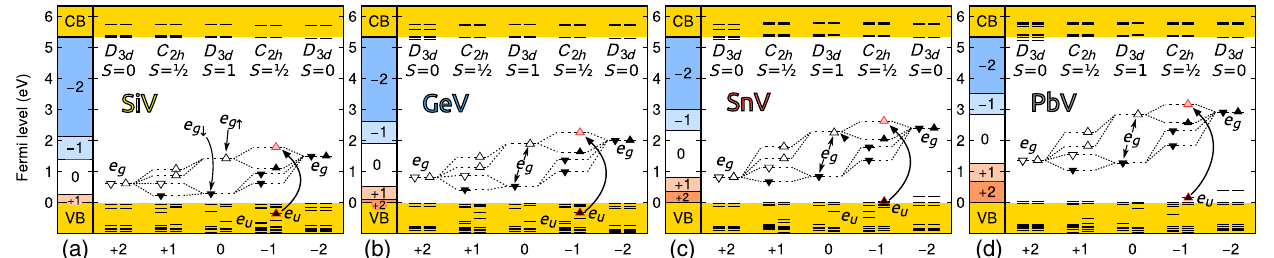
FIG. 1. Kohn-Sham single particle levels and charge transition levels of X V defects for X ¼ Si, Ge, Sn, and Pb in (a) – (d), respectively. We note that the effect of spin-orbit interaction is not included here. We represent the ↑ ( ↓ ) spin channel with triangles pointing upwards (downwards). The filled (empty) triangles depict occupied one electron (hole) orbitals. In the ( þ ) and ( − ) charge states, the symmetry is lowered from D 3 to C 2 within adiabatic potential energy surface in the DFT calculations. We show the charge stability window for the d h given charge state referenced to the valence band maximum of diamond at the left side in each figure, where the conduction band (CB) is also depicted. The excitation processes are also shown for X V ð − Þ color centers. The e orbital is resonant with the valence band that u pops up in the excited electron